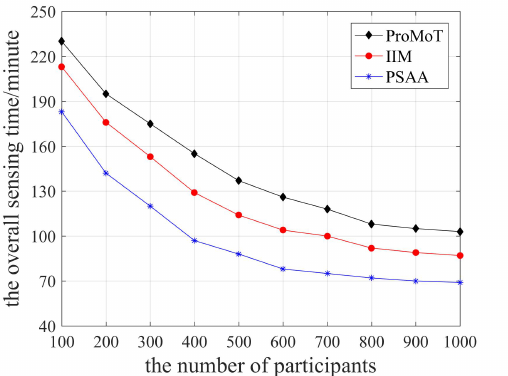
Figure 6. The overall sensing time.